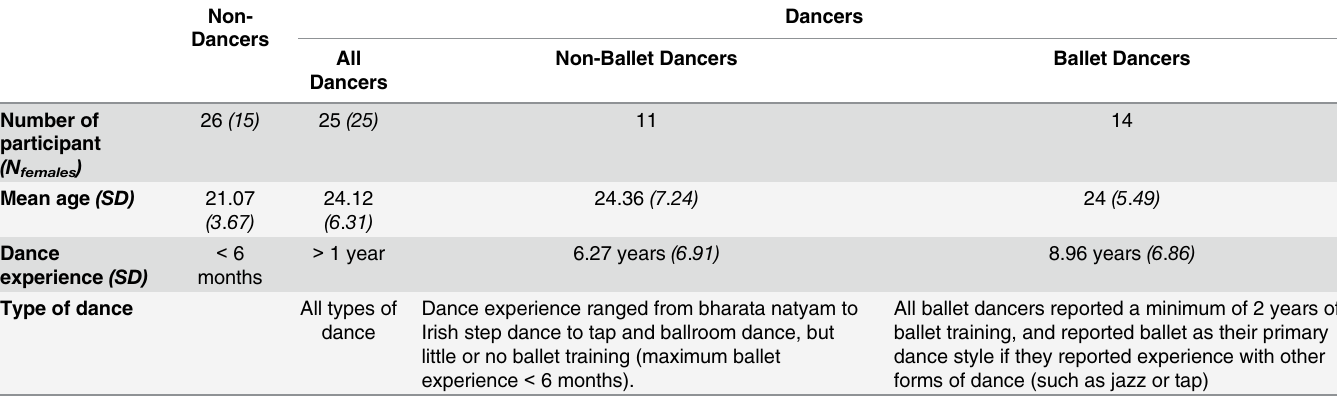
Table 1. Summary of participants demographic and dance experience.